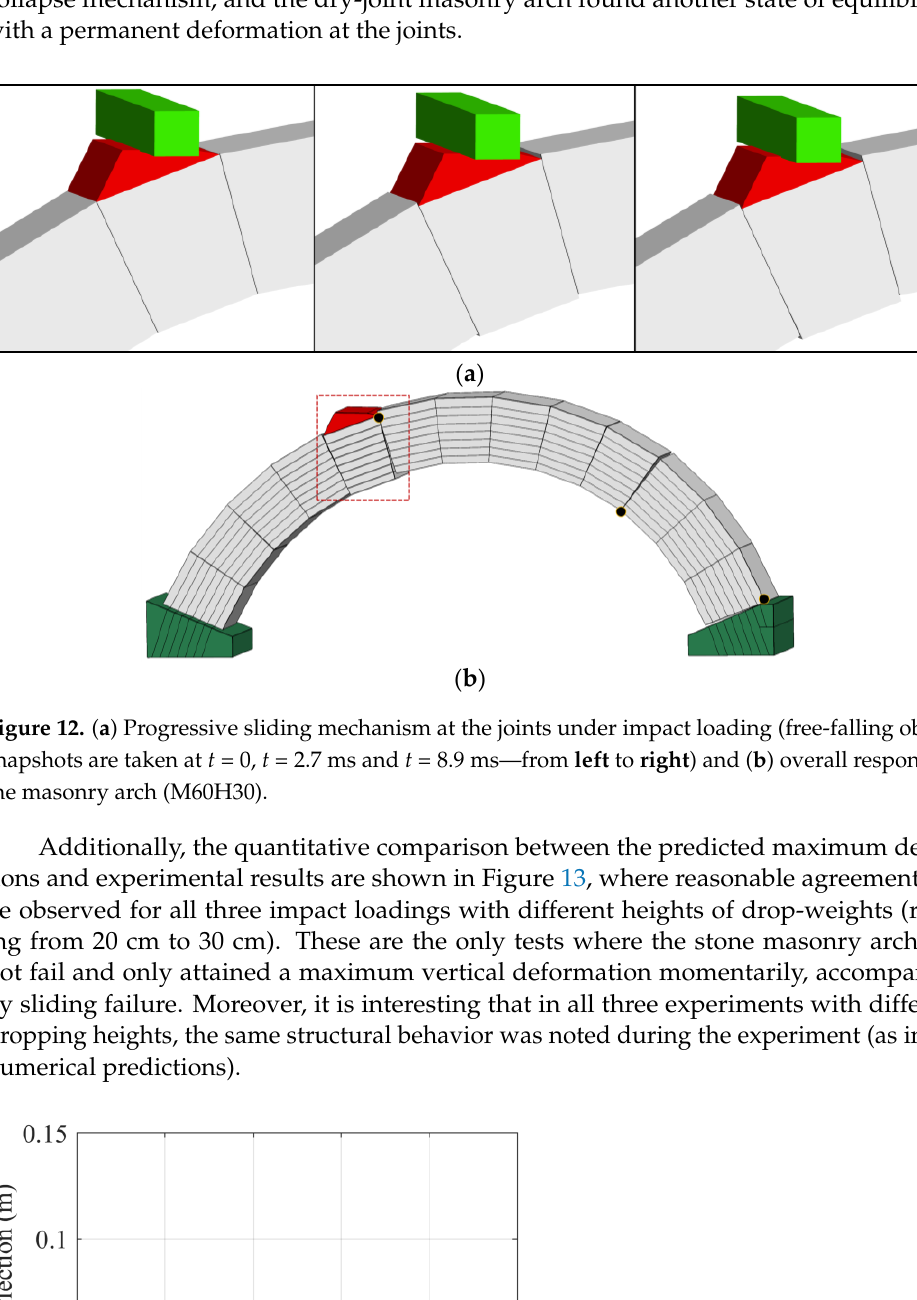
Figure 11. Impact test setup (used in the discrete element model).